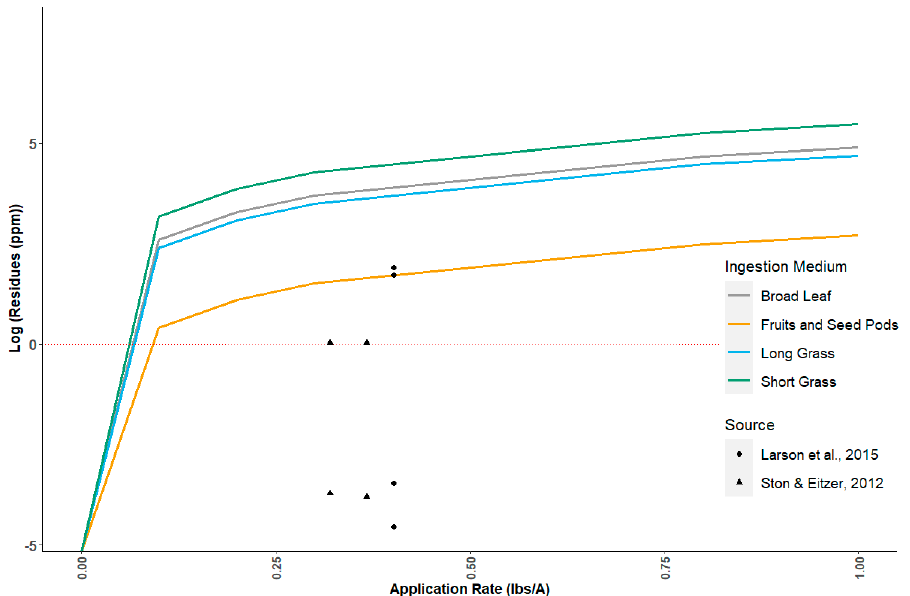
Figure 2. Natural log of estimated imidacloprid residues using the terrestrial residue exposure (T-REX) model guidance for dissipation of a chemical applied to foliar surfaces with ingestion mediums used in MCnest. Nectar residues for imidacloprid spray reported in [73,74] are plotted for comparison against the modeled residues. The model results are biased high as expected since T-REX is intended for screening assessment.